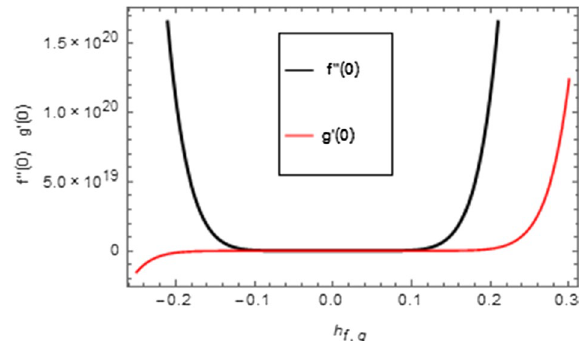
Figure 2. (cid:31) -curves for velocity field and micro-rotation field.